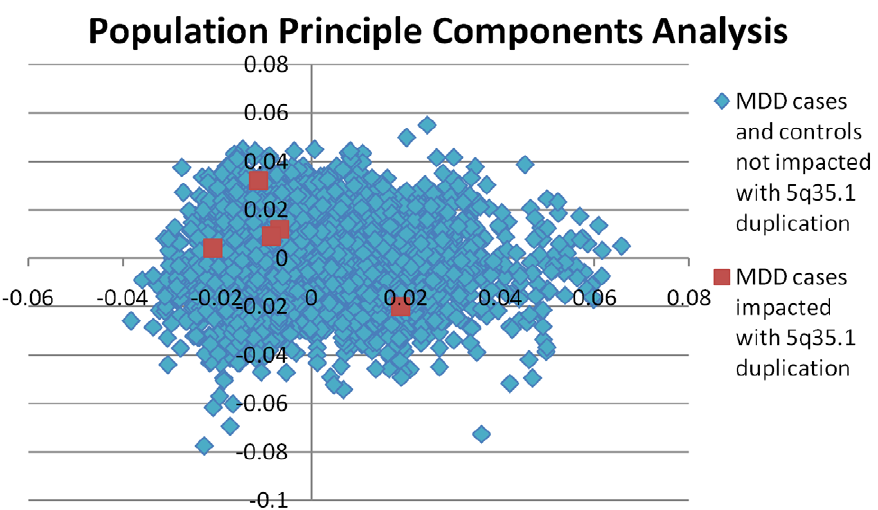
Figure 4. Eigenstrat Principle Components Analysis. The distribution of the second principle component is plotted versus the third principle component. The overall Caucasian population is shown to be homogenous to avoid spurious results arising from population stratification. The five cases with 5q35.1 are shown in red to show that they are representative of the overall population and not in any way outliers. doi:10.1371/journal.pone.0015463.g004 PLoS ONE |